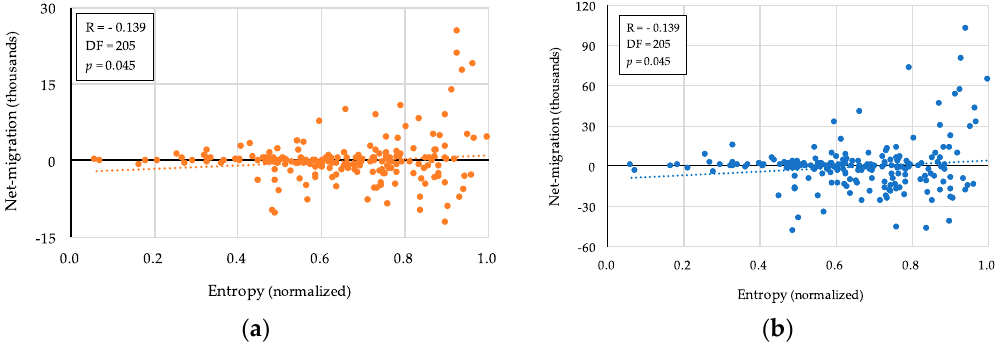
Figure A4. Entropy of the industrial distribution in SIC in 2010 and observed net migration: ( a ) in 2011; and ( b ) during 2011–2015.